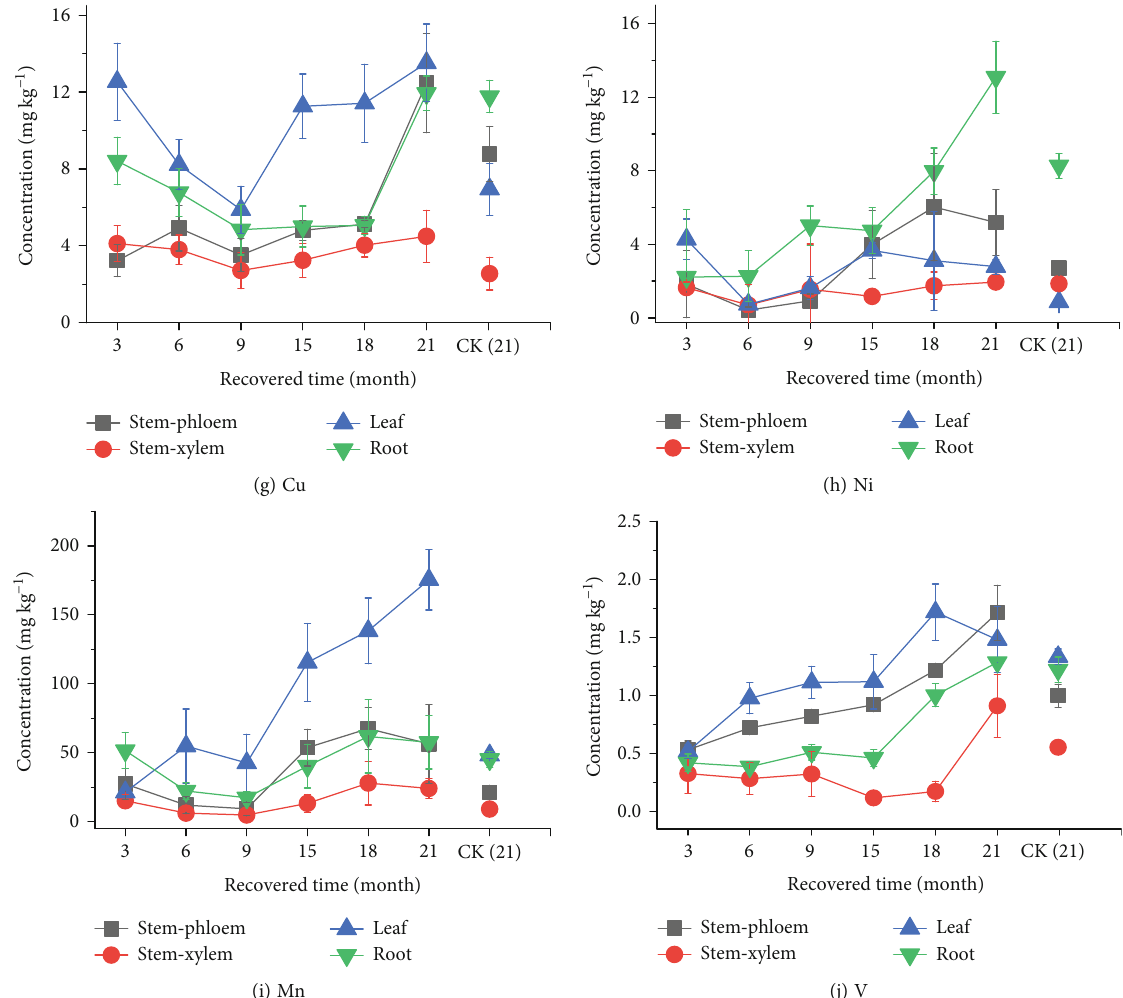
Figure 4: E ff ect of recovery time on contents of heavy metal in di ff erent organs of Indigofera amblyantha Craib. The CK(21) represents the control group at twenty- fi rst month. The error bar was the standard error.